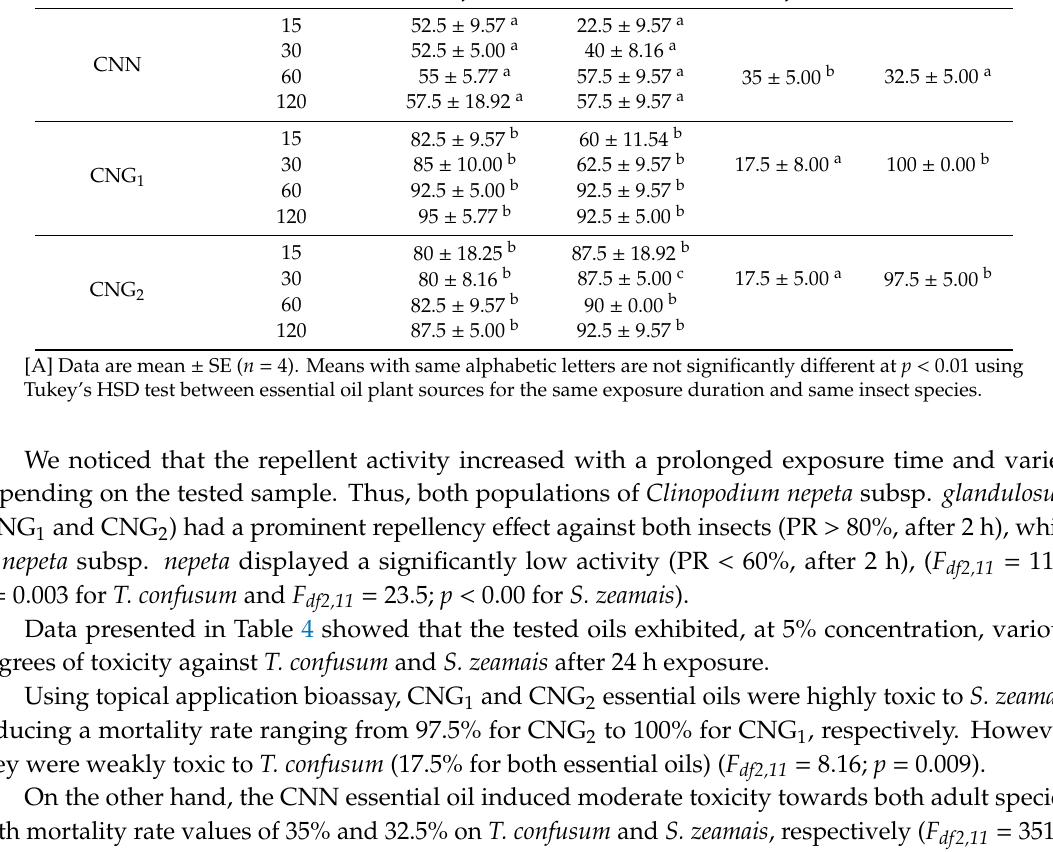
Table 4. Repellency and toxicity of Tribolium confusum and Sitophilus zeamais exposed to the C. nepeta subspecies essential oils (2% and 5% concentrations for repellency and mortality tests, respectively) [A]. Exposure Essential Oils Duration Plant Source